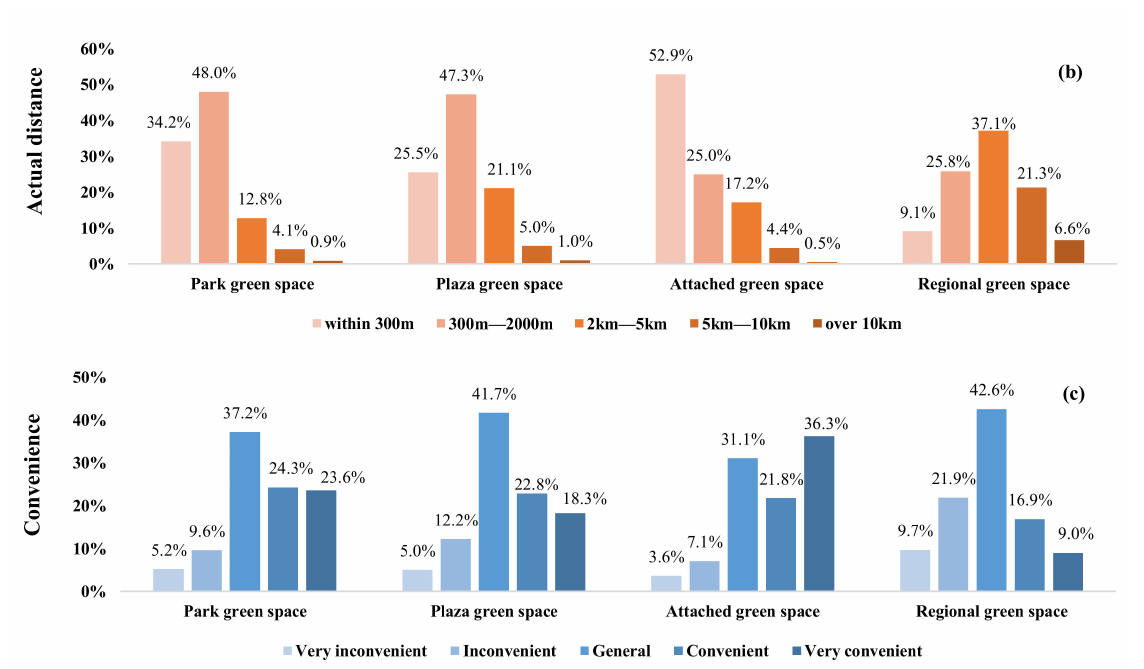
Figure 2. ( a ) The ideal distance of respondents’ residence from different green space types and ( b ) the actual distance of respondents’ residence from different green space types. ( c ) The convenience of residents to the urban green